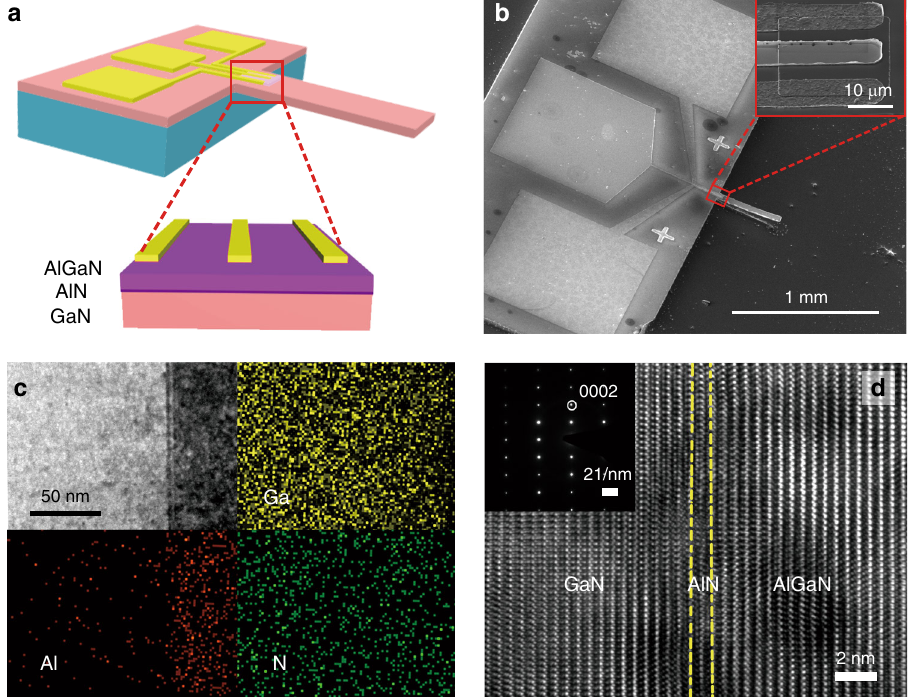
Fig. 2 Characterizations of the SPD. a Schematic illustration of the SPD with the AlGaN/AlN/GaN heterostructures. b Scanning electron microscopy (SEM) image of the SPD. The inset shows a magni fi ed section containing the AlGaN/AlN/GaN-based HEMT. c Cross-sectional high-angle annular dark- fi eld scanning transmission electron microscope (HAADF-STEM) image of the AlGaN/AlN/GaN hetero-stacks in the SPD, and the corresponding energy-dispersive X-ray spectroscopy (EDS) element mapping including Ga, Al, and N. d High-resolution TEM image acquired from the AlGaN/AlN/GaN hetero-stacks. The inset is the corresponding selected area electron diffraction (SAED) of